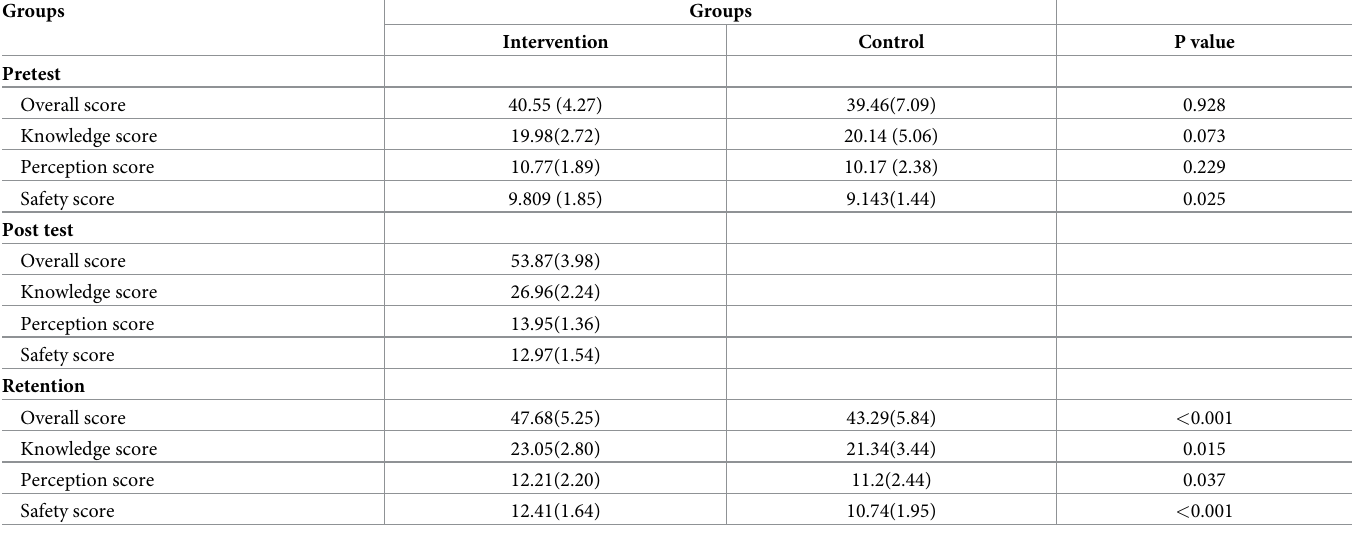
Table 2. Table showing differences of scores of students between intervention group (students that receives rabies education) and control groups (students that did not receive rabies education). Groups Groups Intervention Control P